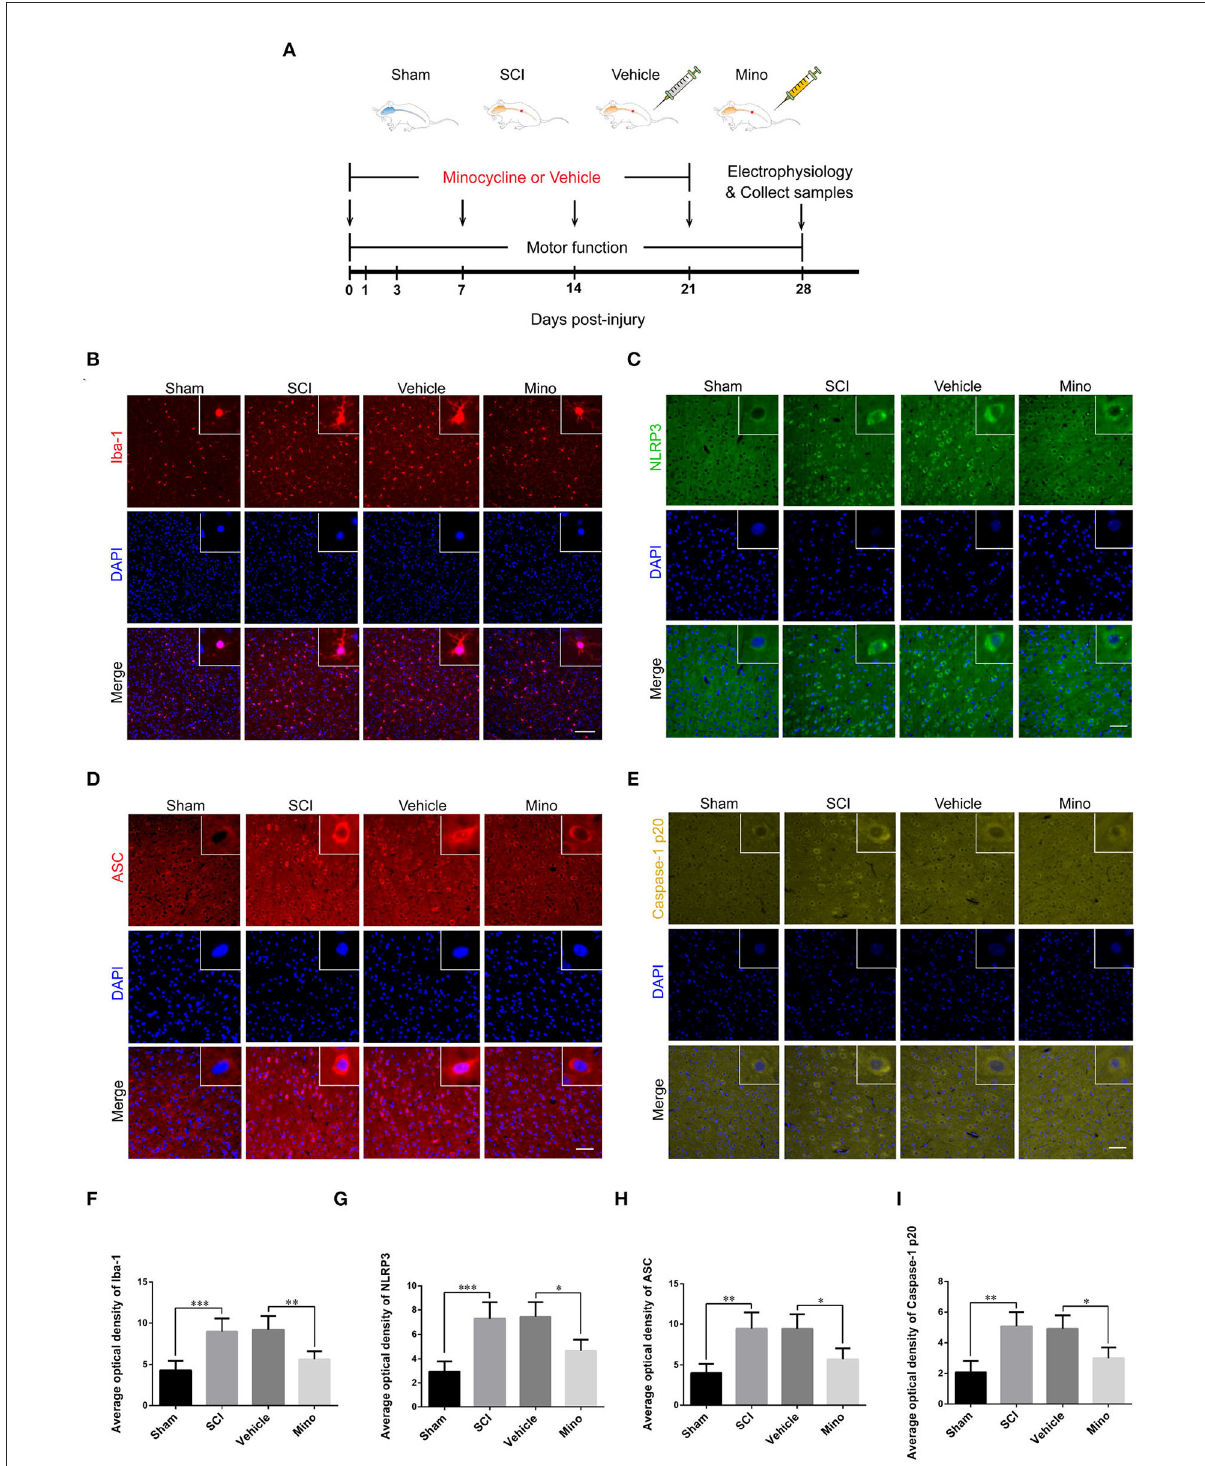
FIGURE1 Microglial activation in M1 mediated Nod-like receptor protein 3 (NLRP3-) related neuroinflammation following spinal cord injury (SCI), which was inhibited by minocycline therapy. (A) Schematic diagram of the groups and study protocols employed in vivo . (B–E) Representative immunofluorescent images of Iba-1, NLRP3, ASC, and caspase-1 p20 in M1 of each group. Scale bars = 100 µ m for Iba-1 and 50 µ m for NLRP3, ASC, and caspase-1 p20. (F–I) The average optical density of Iba-1, NLRP3, ASC, and caspase-1 p20 in M1 of each group [data were presented as means ± standard deviation (SD), n ≥ 4, * p < 0.05, ** p < 0.01, *** p <